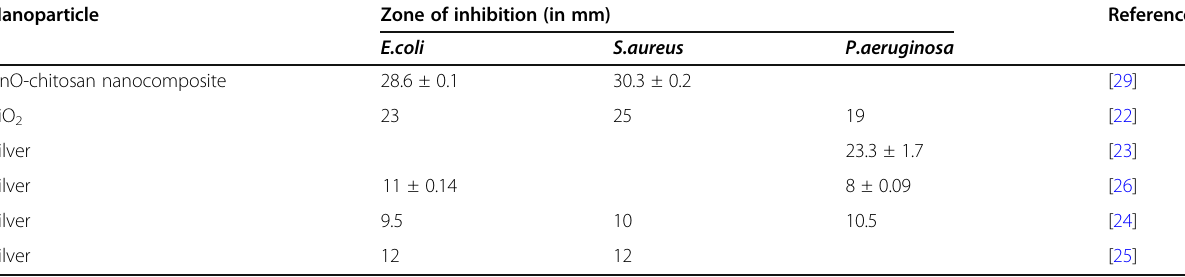
Table 2 Anti-microbial activity (in the form of zone of inhibition) exhibited by P.guajava leaves assisted synthesized nanoparticles against selected microbes